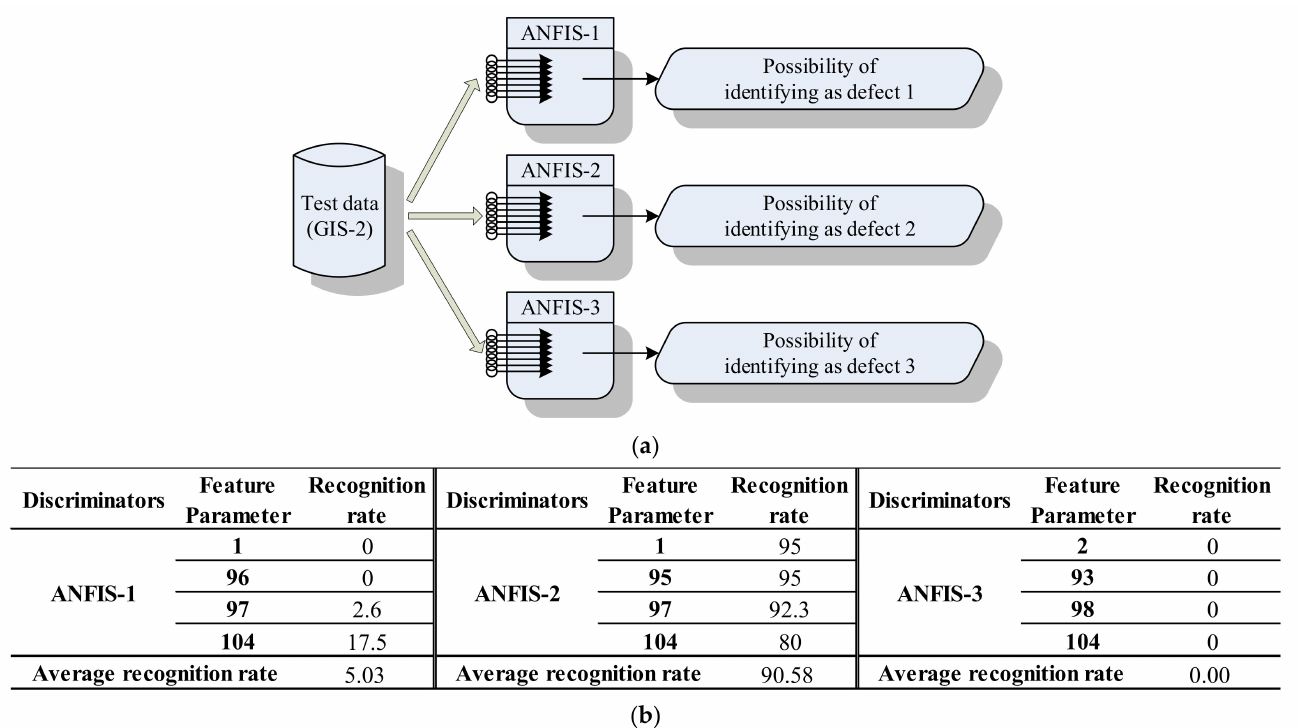
Figure 40. GIS-2 in parallel recognition system: ( a ) test architecture; ( b ) test results.